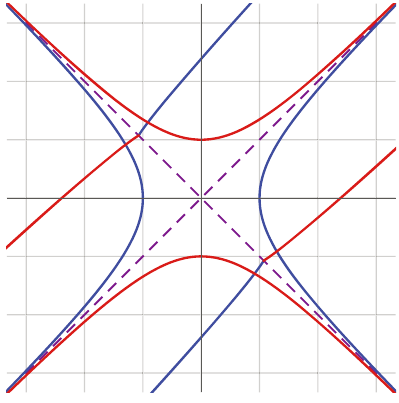
Figure 5: Lorentzian Norwich